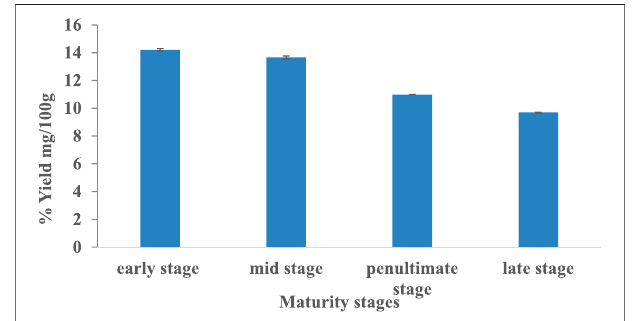
FIGURE 2 | HPLC chromatogram showing separation of phenolics and fl avonoids in the M. oleifera leaf extracts at a late stage.